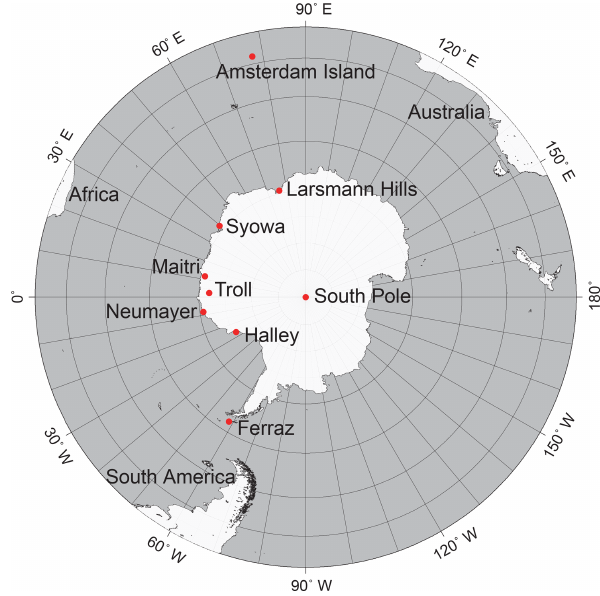
Figure 1. Locations of Syowa Station and other research stations with BC measurements in Antarctica and the Southern Ocean. Red circles represent locations of each